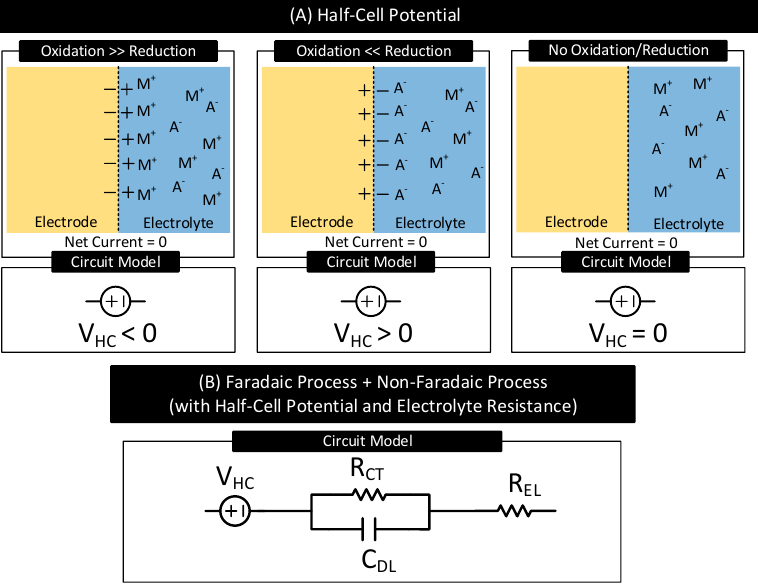
Figure 3. ( A ) Electrode half-cell potential (also known as contact potential), V HC , for three different cases. V HC is positive if at the interfaces, in the beginning, oxidation reactions dominate reduction reactions. V HC is negative if at the interfaces, in the beginning, reduction reactions dominate oxidation reactions. V H C is zero in the absence of oxidation and reduction reactions. ( B ) Circuit model of an electrode–electrolyte interface supporting both faradaic and non-faradaic processes of current transfer with half-cell potential, V HC , and electrolyte resistance, R EL